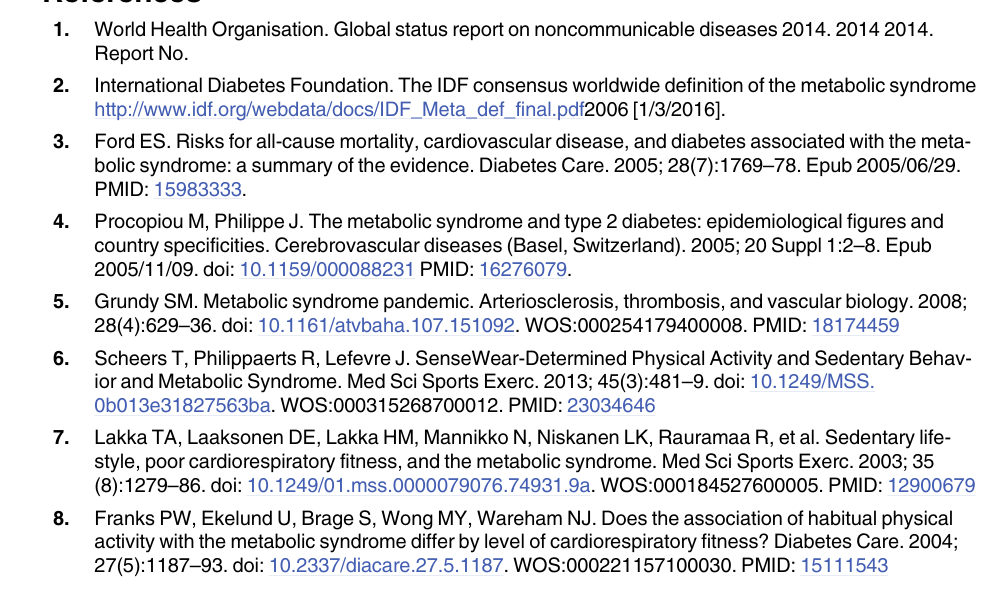
S1 Table. Pearson correlation coefficients for the association between physical activity, sed- entary time, physical fitness and cardio-metabolic markers. S2 Table. Unstandardized regression coefficients of sedentary behavior, moderate-to-vigor- ous physical activity and cardiorespiratory fitness for cardio-metabolic